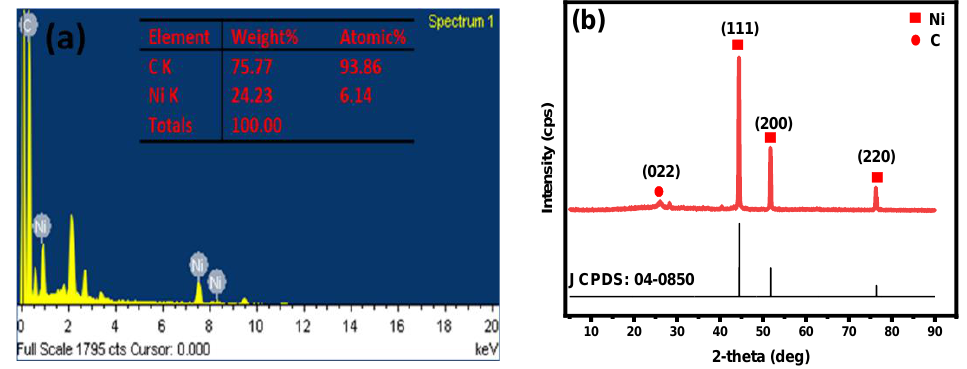
Figure 2. ( a ) EDX profiles and ( b ) XRD spectra of NiNPs@PCFs.